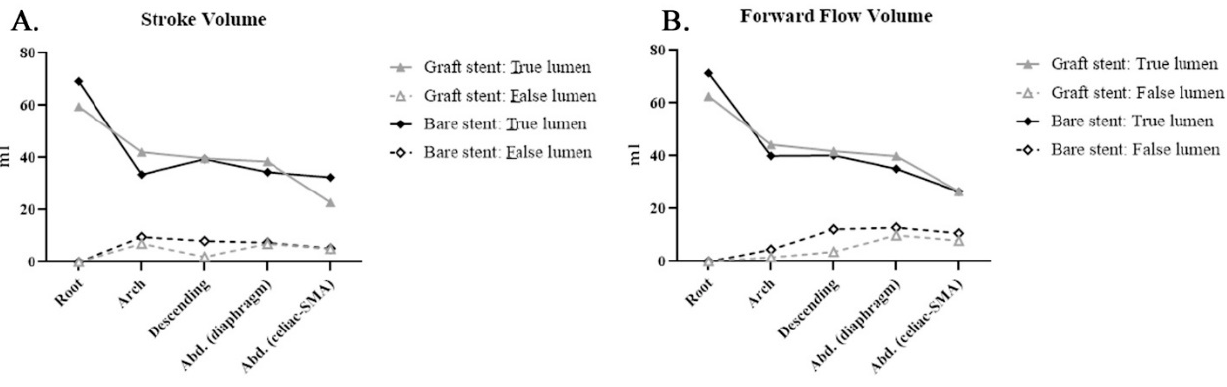
Figure 4. Covered (graft) stent and bare stent: Phase-contrast magnetic resonance imaging (PC-MRI) quantitative flow measurements after thoracic endovascular aortic repair (TEVAR) compared with those before TEVAR: ( A ) stroke volume (SV): SV exhibited a similar distribution between false and true lumens; ( B ) forward flow volume (FFV): FFV exhibited a similar distribution between false and true lumens; ( C ) backward flow volume (BFV): BFV in the false lumen was higher in patients with bare stents than in those with covered stents; ( D ) regurgitant fraction (RF): RF in the false lumen was higher in patients with graft stent than in those with bare stents. Figure 5. Covered (graft) stent and bare stent: Phase-contrast magnetic resonance imaging (PC-MRI) quantitative flow measurements after thoracic endovascular aortic repair (TEVAR) compared with those before TEVAR: ( A ) absolute stroke volume (ASV): ASV in the false lumen was higher in the bare stent group, indicating fewer communicator occlusions by the bare stent in the thoracic aorta; ( B ) mean flux (MF): MF was higher in the true lumen in patients with bare stents; ( C ) stroke distance (SD): SD in the true lumen was smaller in patients with bare stents than in those with covered stents after thoracic endovascular aortic repair (TEVAR); ( D ) mean velocity (MV): MV was higher in the descending segment but lower in the abdominal aorta in the bare stent group than in the covered stent group after TEVAR.